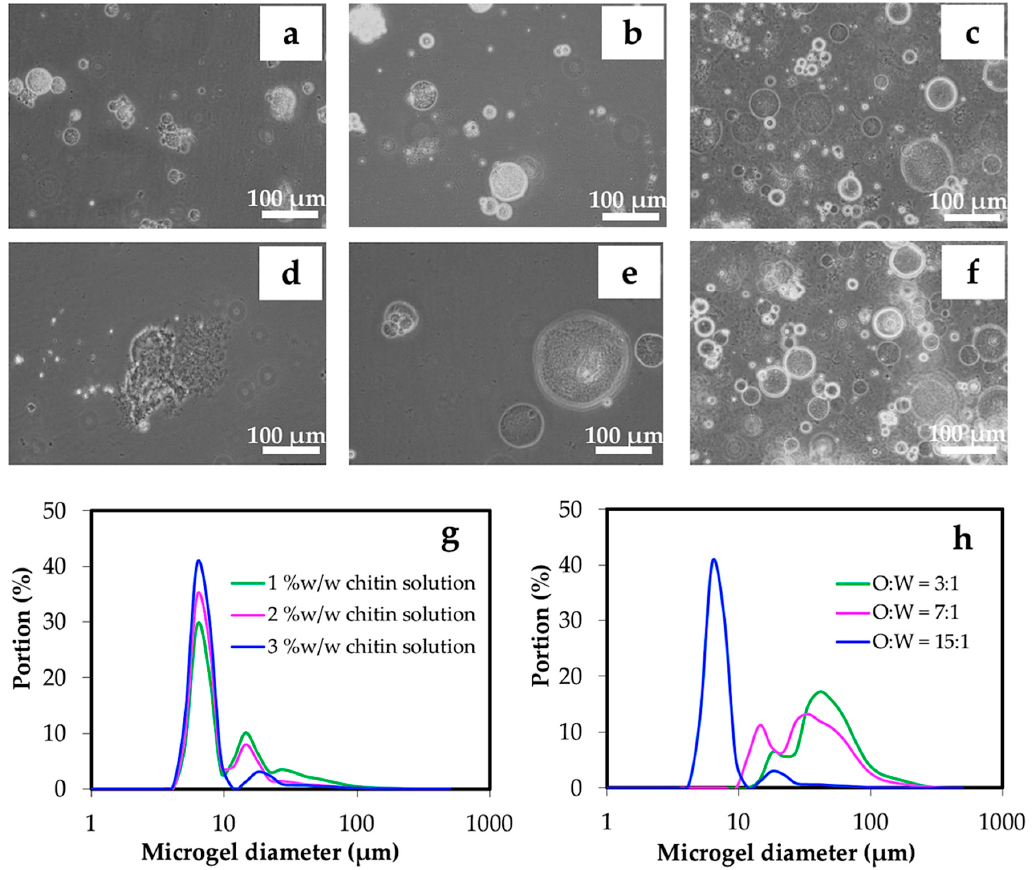
Figure 5. Optical microscopic images of microgels prepared from chitin solution at the concentrations of 1% w / w ( a ), 2% w / w ( b ), and 3% w / w ( c ), and O:W of 3:1 ( d ), 7:1 ( e ), and 15:1 ( f ) by controlling the concentration of Span 80 (HLB 4.3) at 5% w / w in oil phase. Gelation was carried out using 800 µ L of 1.0 M HCl. The representative size distributions of microgels prepared by different chitin concentrations and O:W ratios are shown in ( g ) and ( h ), respectively.